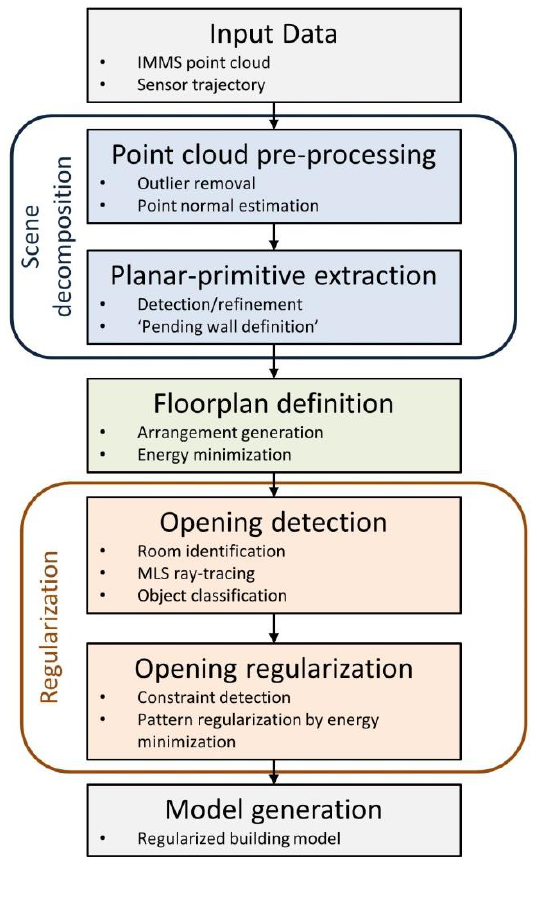
Figure 1. Workflow of the indoor reconstruction procedure.